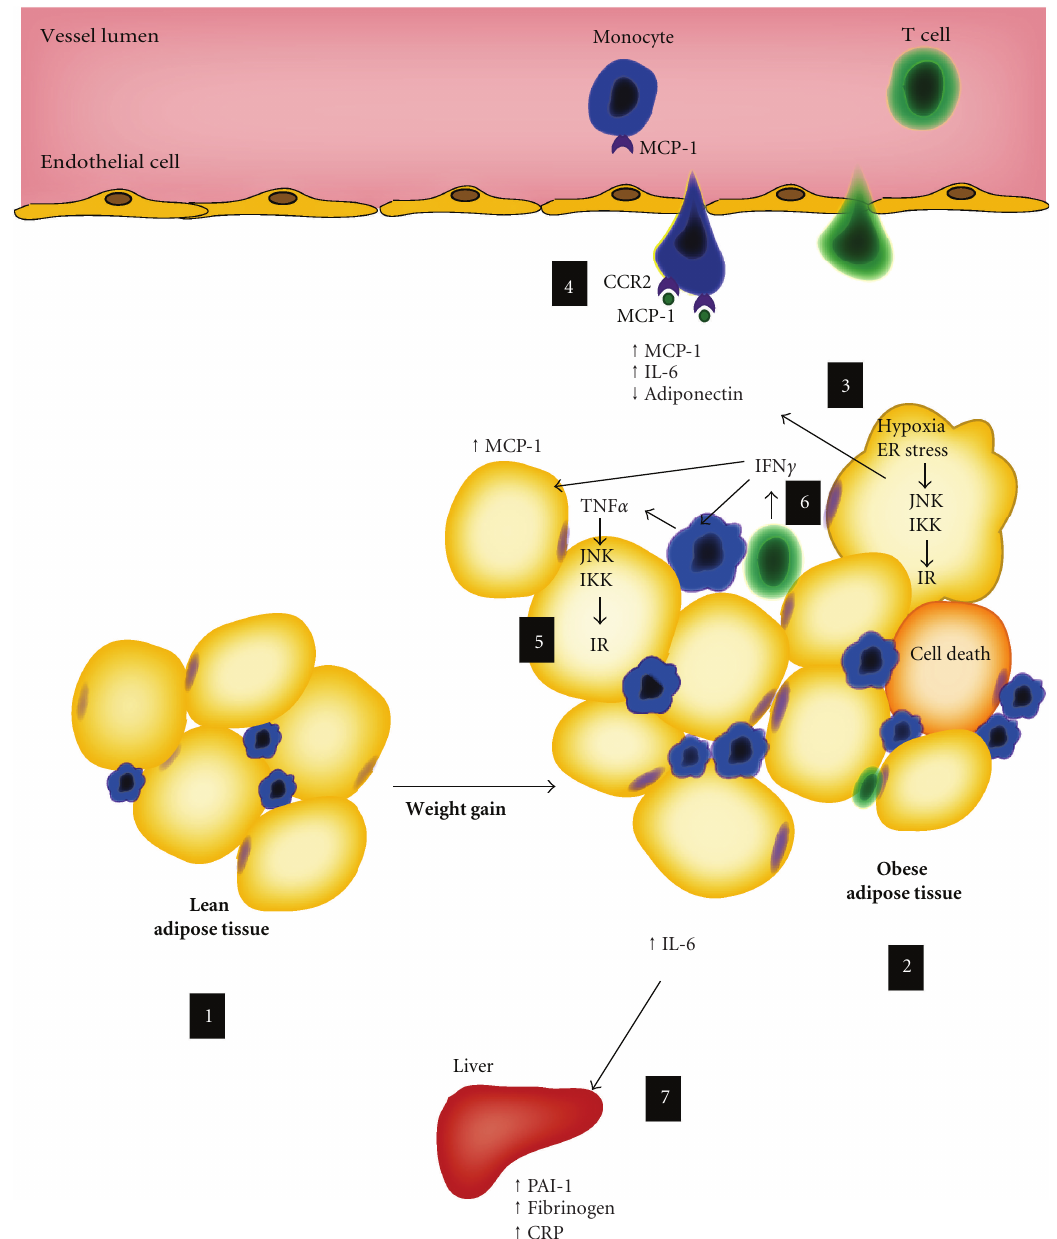
Figure 1: Adipose tissue inflammation in obesity. Whereas lean adipose tissue contains a population of resident inflammatory cells (1) and secretes various active substances, the obese adipose tissue (2) accumulates higher numbers of macrophages and T cells, producing copious amounts of inflammatory mediators, such as monocyte chemoattractant protein-1 (MCP-1) and interleukin-6 (IL-6), and less adiponectin (3). In the context of nutrient surplus and hypoxia, expanding adipocytes present endoplasmic reticulum (ER) stress (3), important trigger of inflammatory kinases, such as JNK and IKK, which can ultimately inhibit insulin signaling (further detail in the text) and activate inflammatory cascades and the production of inflammatory mediators. Existing evidence suggests that higher production of chemokines, such as MCP-1, within the obese adipose tissue could enhance local macrophage accumulation (4). Once in the tissue, monocyte-derived macrophages can be a fundamental source of tumor necrosis factor-alpha (TNF α ), among other mediators. Cytokines like TNF α and other stimuli can cause further activation of inflammatory kinases (5). Several studies have demonstrated that T cells also accumulate in adipose tissue in the obese state (6). Interferon-gamma (IFN γ ), a typical T-helper 1 cytokine, likely regulates local expression of TNF α , MCP-1, and other inflammatory mediators, suggesting a role for adaptive immunity in obesity pathophysiology. The spillover of adipokines, such as IL-6, into the circulation can also promote important systemic e ff ects (7), such as increased production of liver-derived acute-phase inflammatory mediators and coagulation-related factors, most of them likely correlated with